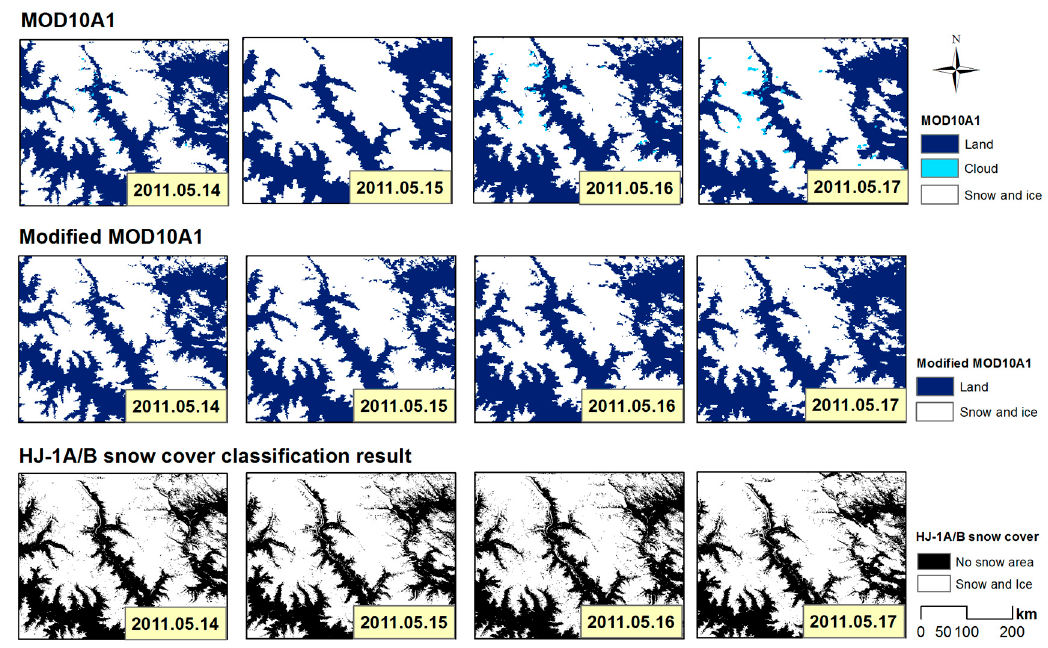
Figure 10. Comparison of snow cover determined from MOD10A1 data, modified MOD10A1 data, and HJ-1A/B data on 14–17 May 2011. Table 2. SCPs, SCP differences, and overall accuracies (OAs) of snow cover data extracted from